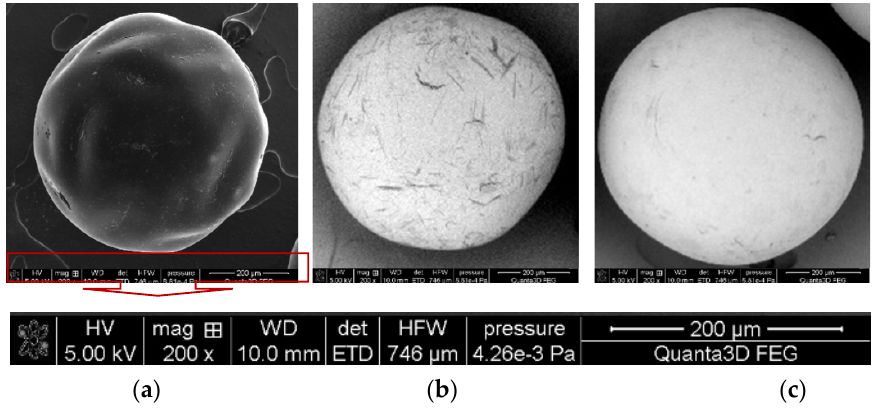
Figure 3. Chosen examples of SEM images of ( a ) AF5, ( b ) A830, and ( c ) SR7 (magn. 200×).